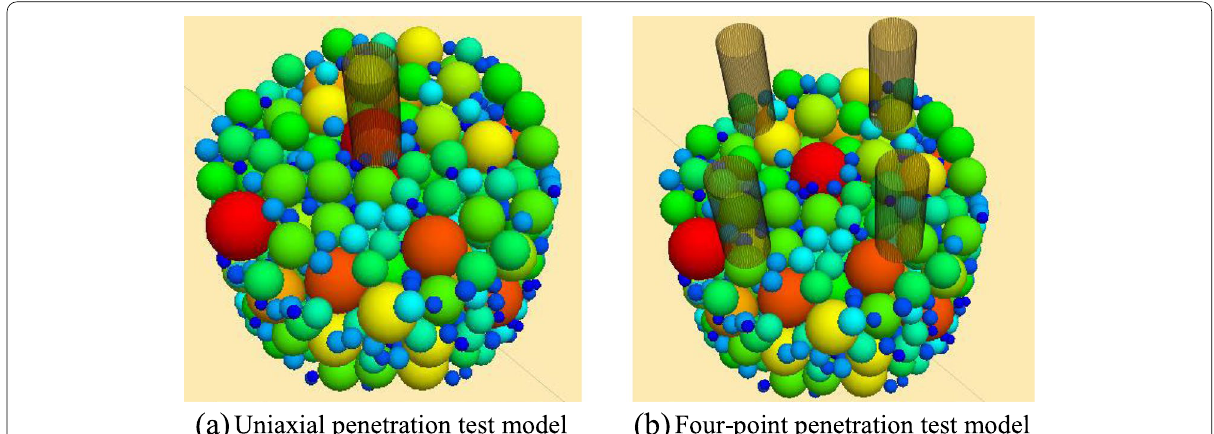
Fig. 6 Penetration test model of asphalt mixture skeleton particles. (a) Uniaxial penetration test model. (b) Four-point penetration test